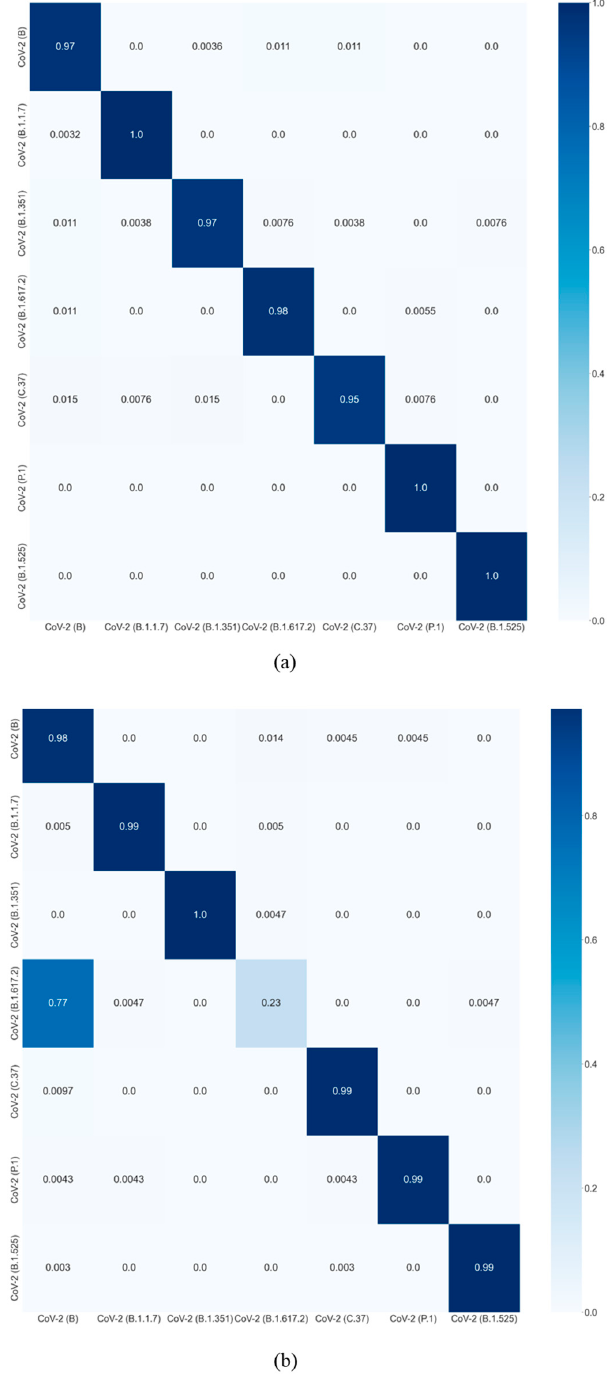
Figure 5. The confusion matrix attained using the proposed attention-CNN for the test set of ( a ) nucleotide sequences and ( b ) protein